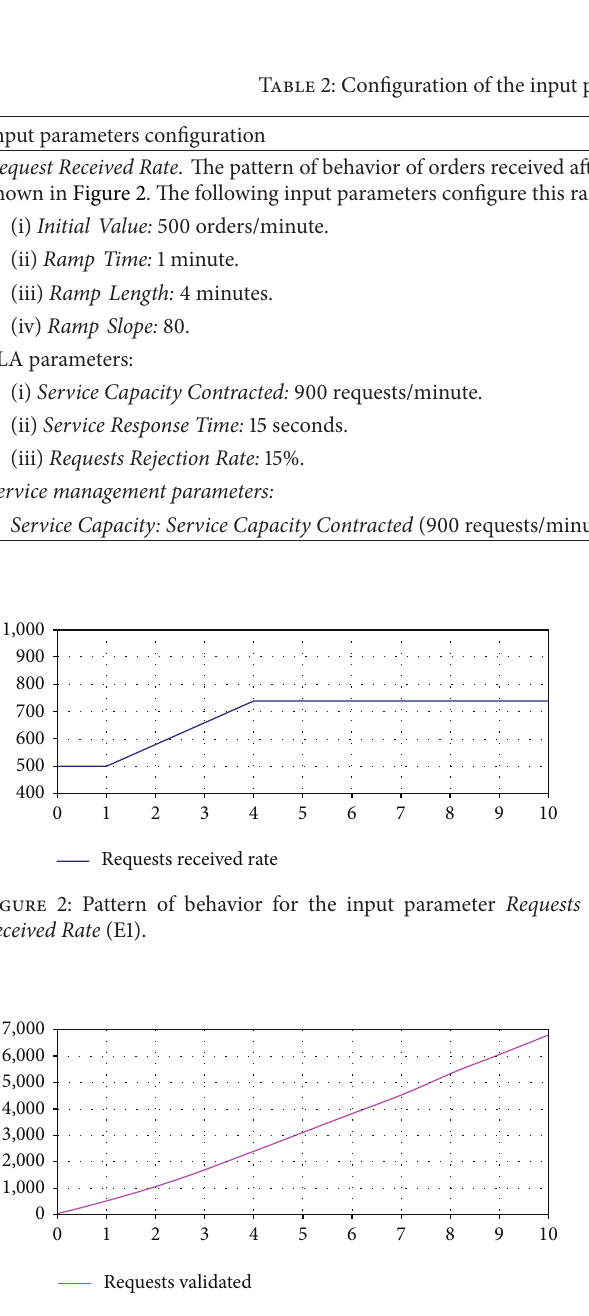
Figure 3: Output variable Requests Validated (E1).